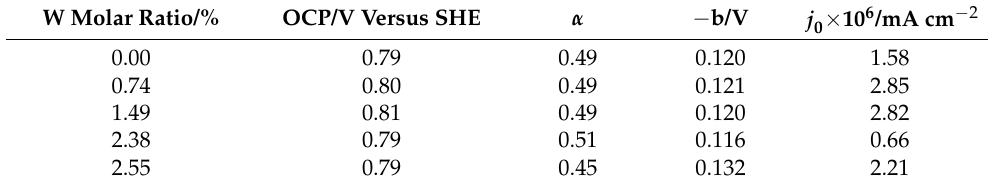
Table 2. Electrochemical parameter of the Co–W–Se catalysts for the ORR in 0.5 M H 2 SO 4 . W Molar